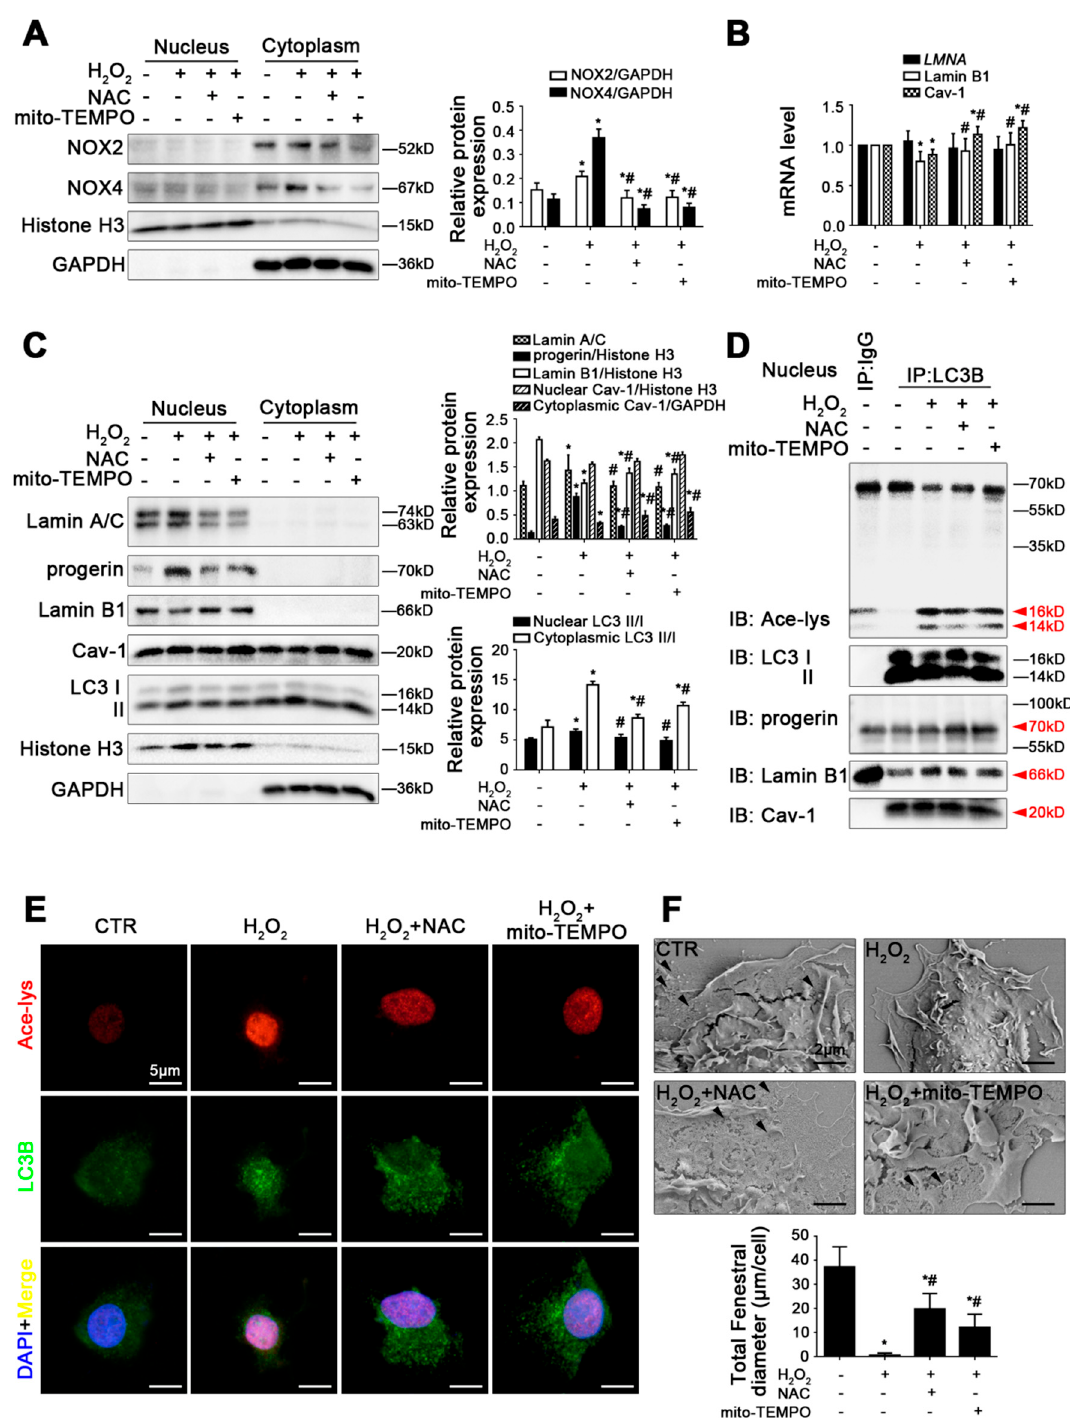
Figure 5. Antioxidants promote progerin nucleophagic degradation and reverse depletion of Lamin B1 and Cav − 1 to maintain LSEC fenestrae. Fresh rat primary LSECs, isolated from normal male SD rats, were pre − treated with NAC (1 mM) or mito − TEMPO (100 U/mL) and stimulated with H 2 O 2 (10 μ M) in vitro for 48 h. ( A ) Representative immunoblots of NOX2 and NOX4 in nucleus and cytoplasm of primary LSECs in the four groups (CTR, H 2 O 2 , H 2 O 2 +NAC, H 2 O 2 +mito − TEMPO). The relative protein expression was quantified in the graph (right). * p < 0.05 versus the control group; # p < 0.05 versus the H 2 O 2 group. ( B ) RT − qPCR analysis for mRNA levels of LMNA , Lamin B1, and Cav-1 of primary LSECs in the four groups. * p < 0.05 versus the control group; # p < 0.05 versus the H 2 O 2 group. ( C ) Representative immunoblots of Lamin A/C, progerin, Lamin B1, Cav − 1, and LC3 II/I in nucleus and cytoplasm of primary LSECs in the four groups. The relative protein expression and